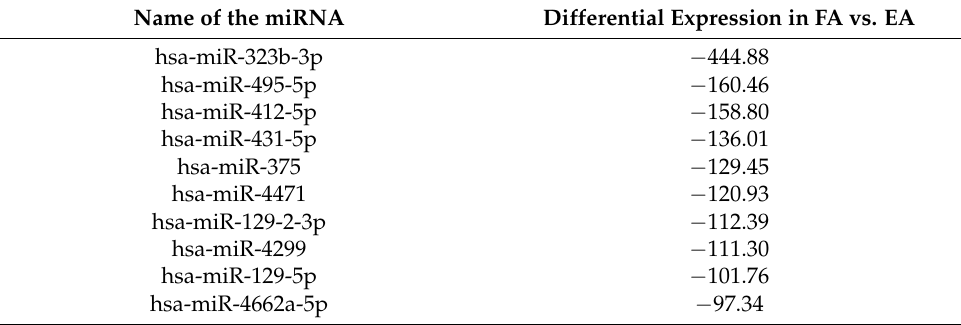
Table 1. Top ten downregulated miRNAs (FA vs.